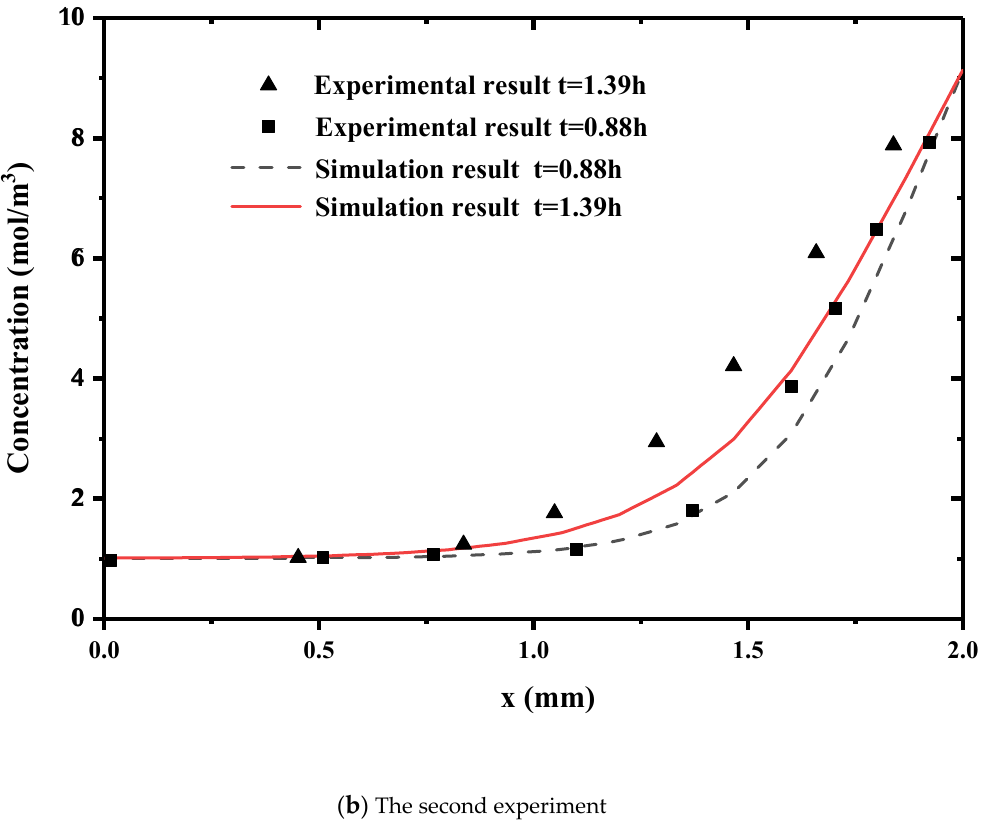
Figure 2. Comparison of our numerical simulations with experimental data. (( a ) the Concentration distribution in the same direction as temperature difference. ( b ) Concentration distribution in the opposite direction of the difference in concentration and temperature).